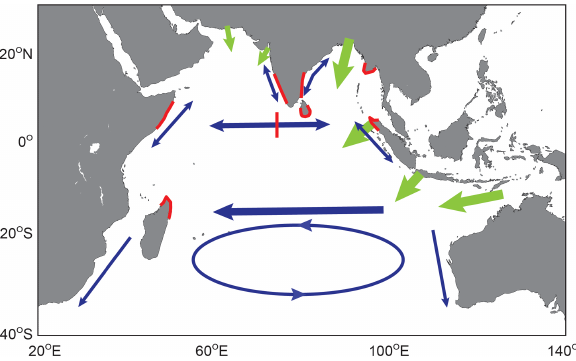
Figure 10. Schematic showing major plastic sources (green ar- rows), plastic transport pathways (blue arrows), and major beaching locations of plastics (red regions) in the Indian